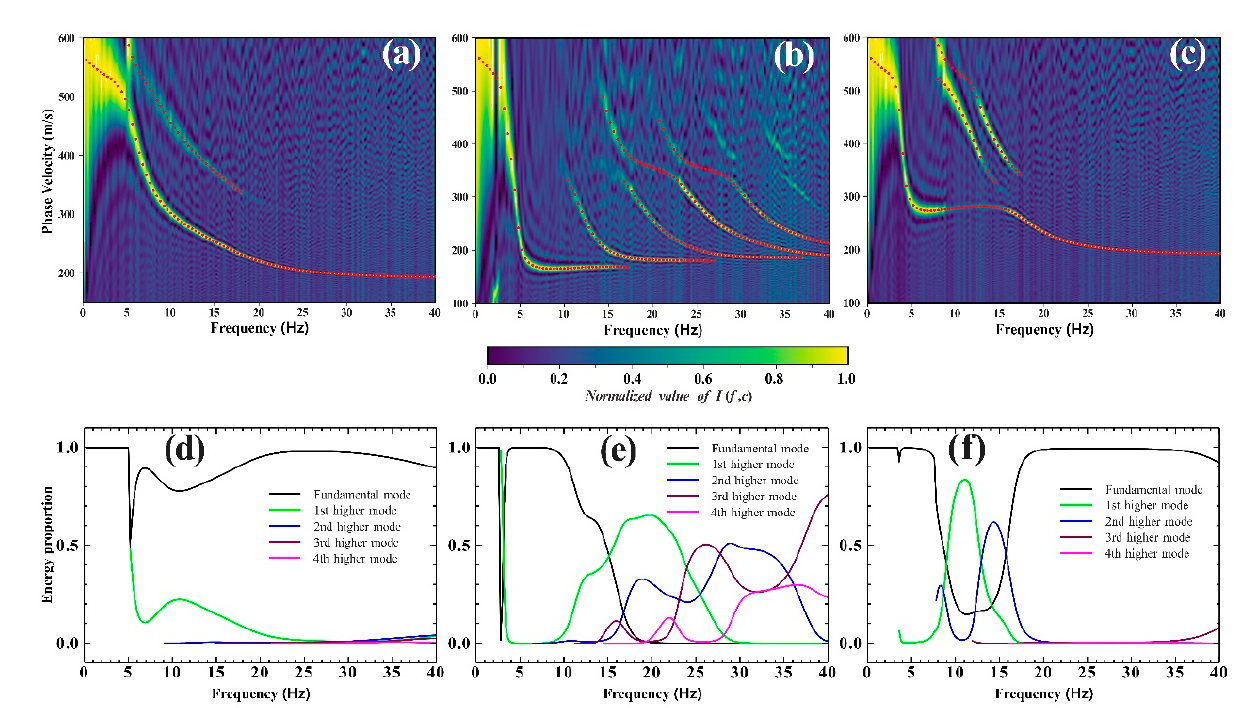
Figure 3. The Rayleigh wave dispersion diagram extracted from the synthesized microtremor signals and the energy proportions of the fundamental and the first three high-order Rayleigh waves corresponding to the three geological models. Red dots and lines represent the dispersion curves of fundamental and higher-order Rayleigh waves calculated theoretically. ( a , d ) Model 1; ( b , e ) Model 2; ( c , f ) Model 3.